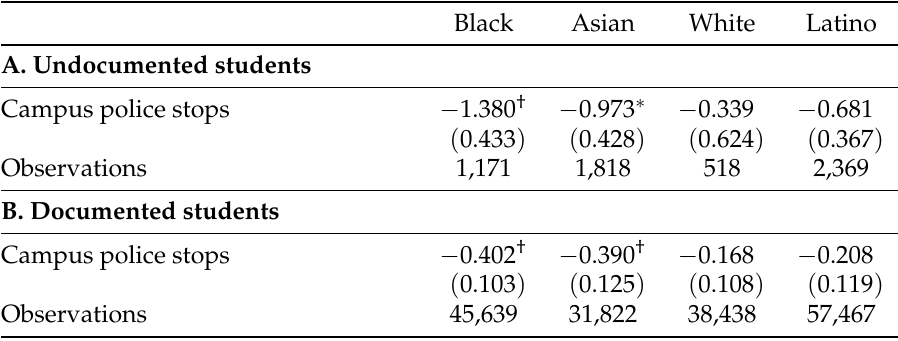
Table 4: Effect of campus police stops on course credits by documentation status